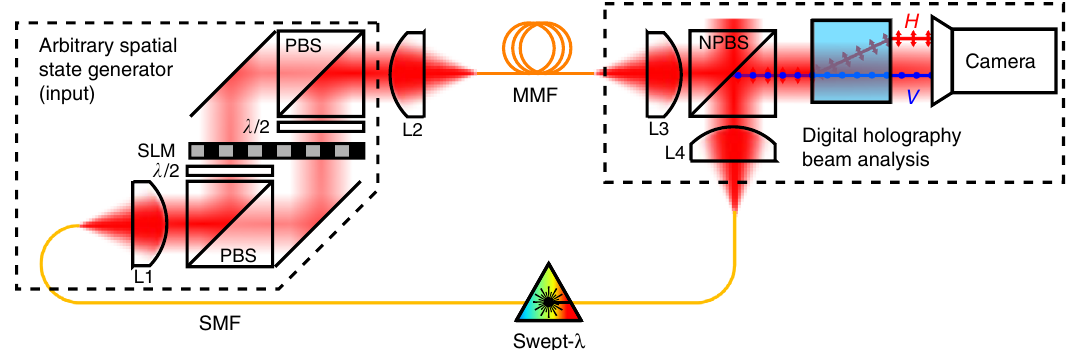
Fig. 1 Apparatus of the experimental setup. SMF: single mode fi ber; SLM: spatial light modulator; PBS: polarizing beam splitter; MMF: multimode fi ber; NPBS: non-polarizing beam splitter; (L1, L2, L3, and L4): optical lenses. Focal length: L1: 25 mm; L2: 10 mm; L3: 4 mm; and L4: 60